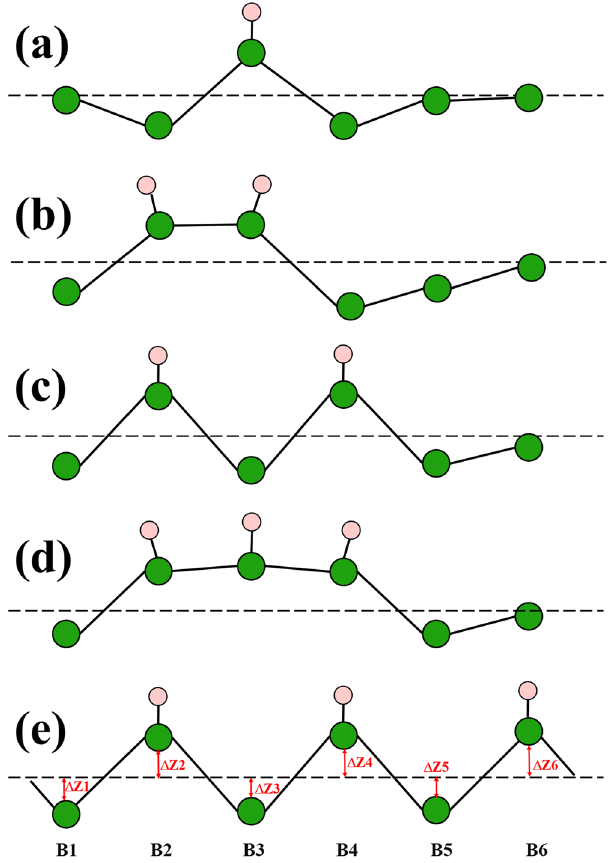
Figure 1. The local atomic structure schematic of borophene with one, two and three H atoms adsorption. ( a ) H1, ( b ) H2-A, ( c ) H2-B, ( d ) H3-A and ( e ) H3-B.